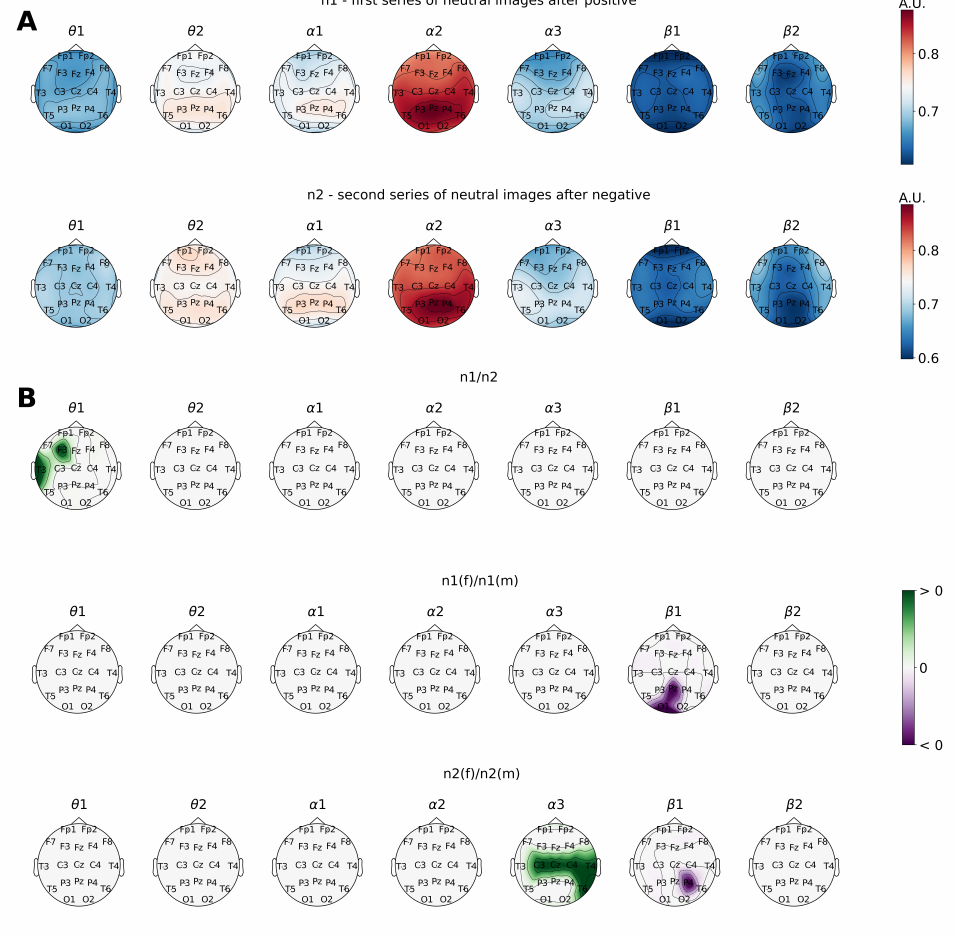
Figure 7. Topographical distribution ( A ) and regions of statistically significant differences ( B ) in DMA scaling exponent